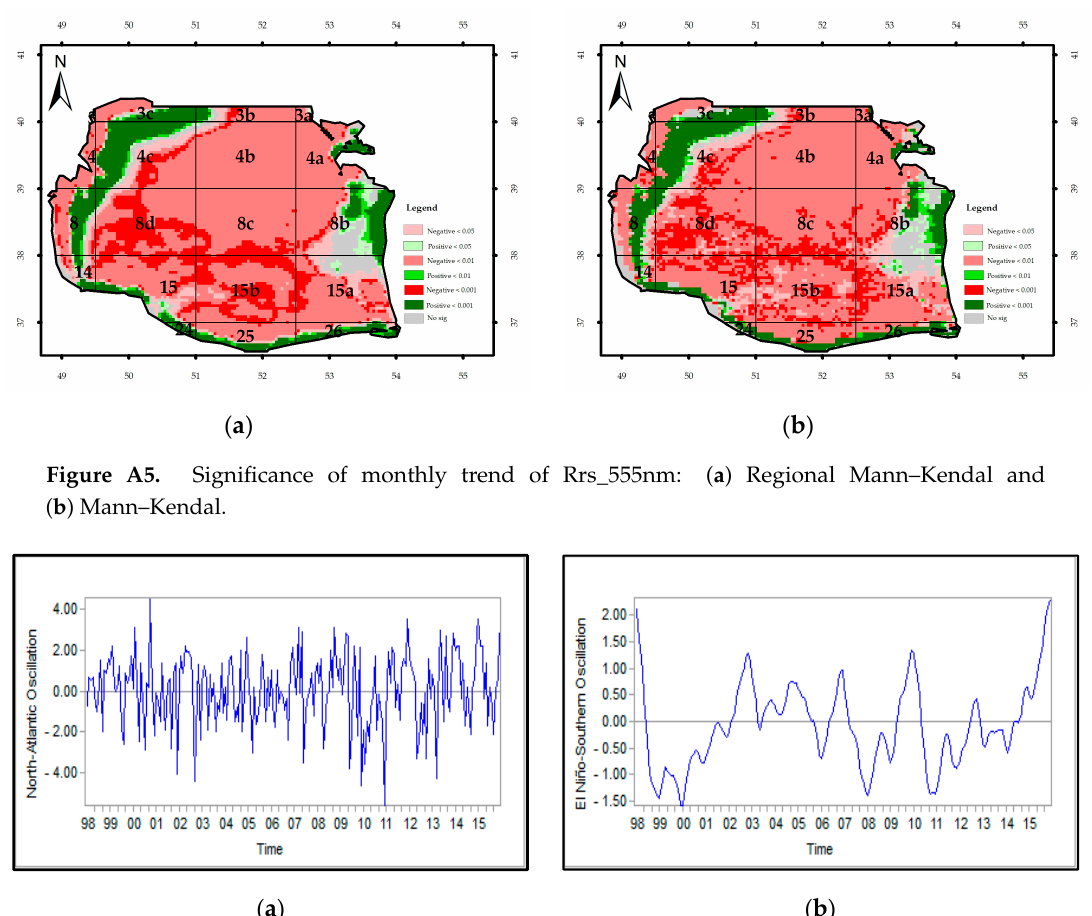
Figure A4. Significance of the monthly trend of the attenuation coefficient: ( a ) regional Mann–Kendal and ( b ) Mann–Kendal.